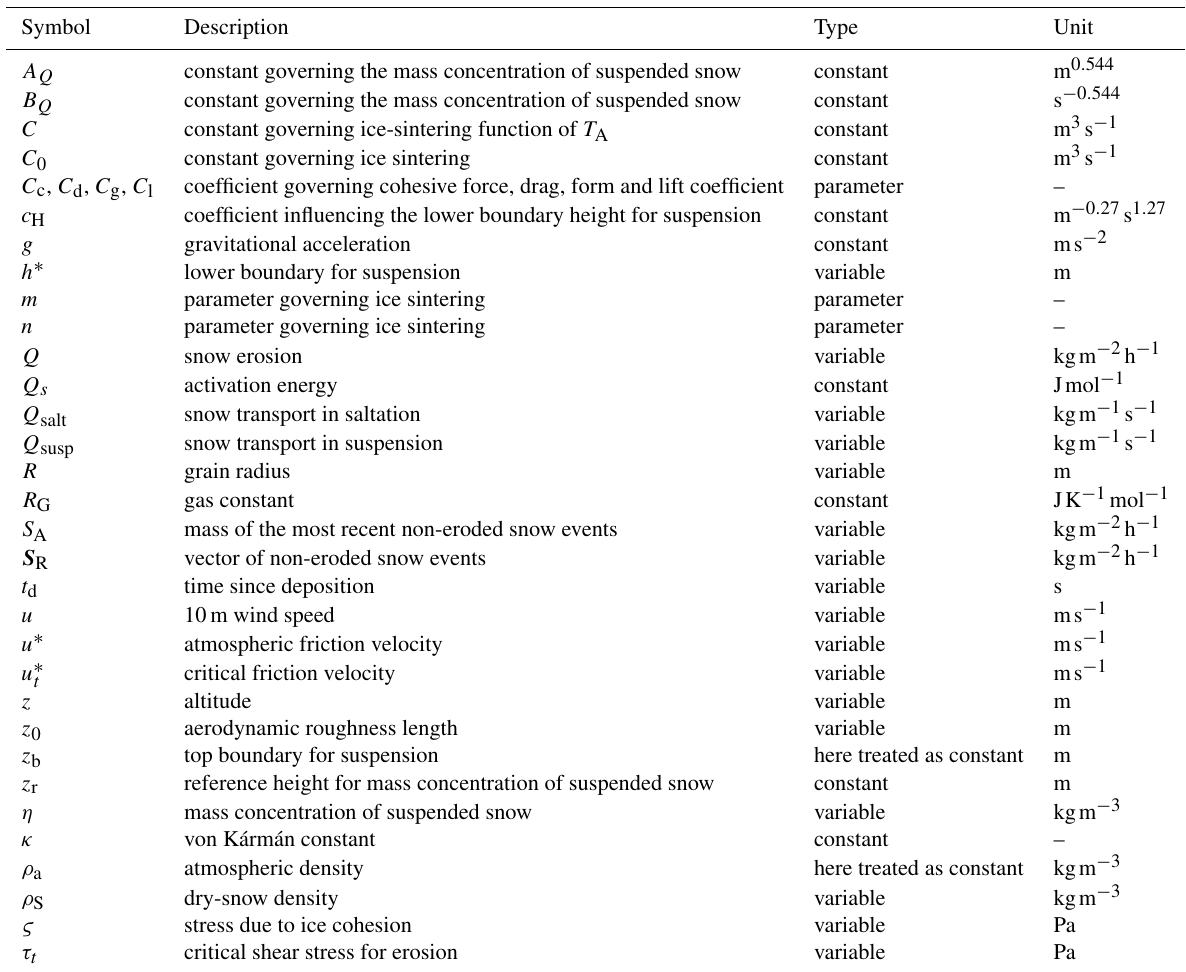
Table B3. List of the symbols used to compute snow erosion.